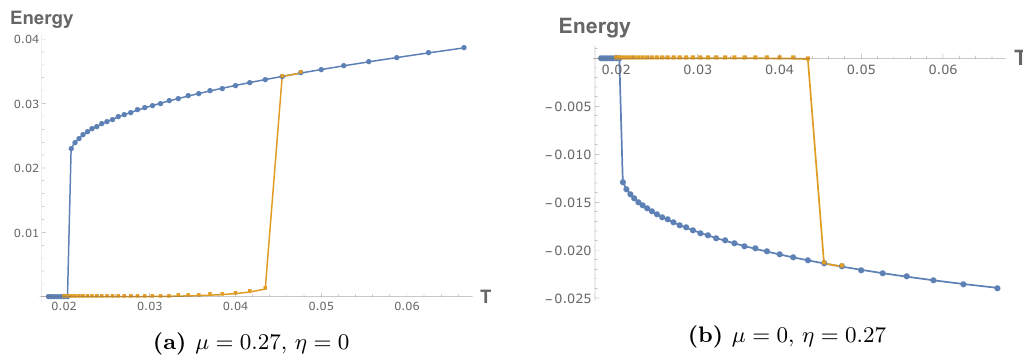
Figure 3. Plots of energy as a function of temperature T for the two different phases. The blue curves are for the liquid phase. The orange curves are for the dilute gas